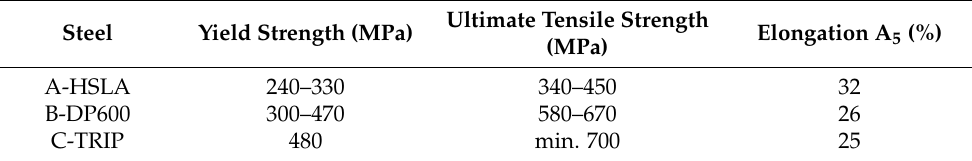
Table 2. Mechanical properties of the evaluated sheets specified by the manufacturer.